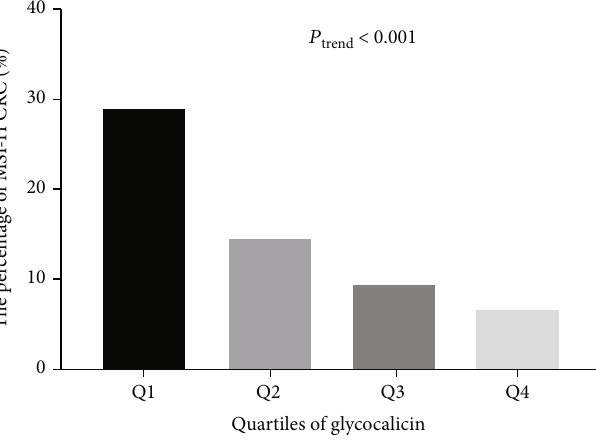
Figure 2: The association between high microsatellite instability and glycocalicin levels among colorectal cancer